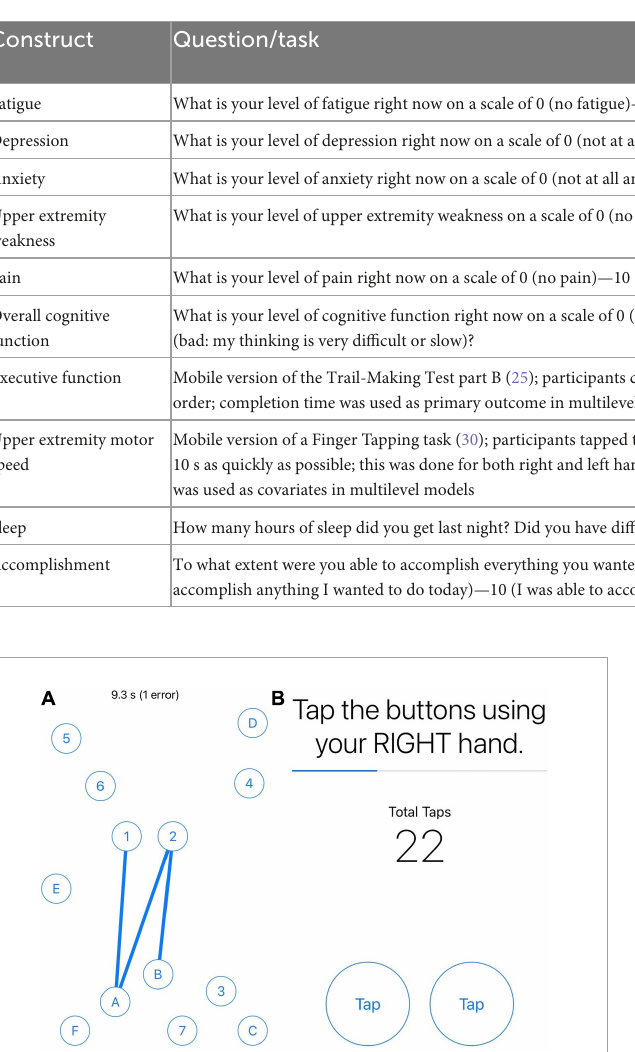
TABLE 1 Ecological momentary assessment protocol.